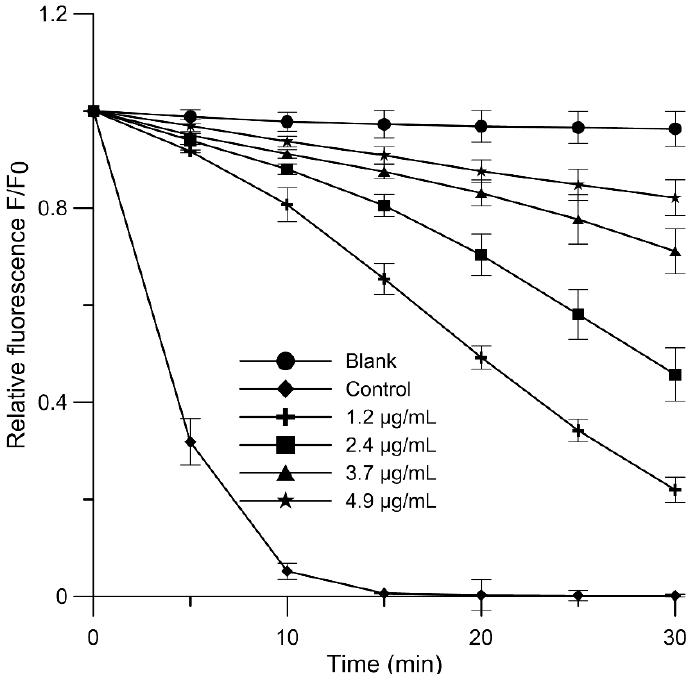
Figure 2. Relative fluorescence intensity of DPH-PA probe as a function of oxidation time of MM membranes for AAPH radical in the presence of elderberry extract at chosen concentrations. The relative changes in fluorescence intensity F/F 0 are a measure of the degree of lipid peroxidation, ( F 0 — fluorescence in the control sample, F —fluorescence of samples in the presence of study